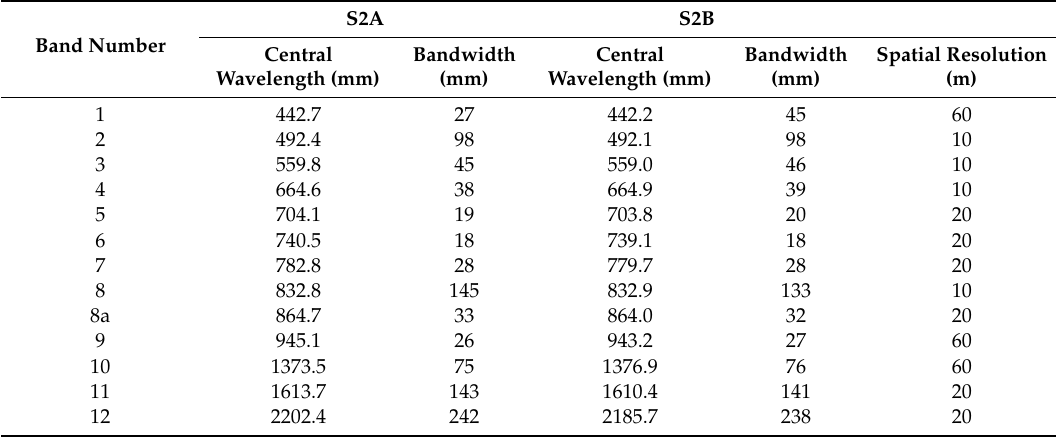
Table 1. The central wavelength, bandwidth and spatial resolution of the 13 bands of the Multi-Spectral Instrument (MSI) instruments onboard Sentinel-2A and